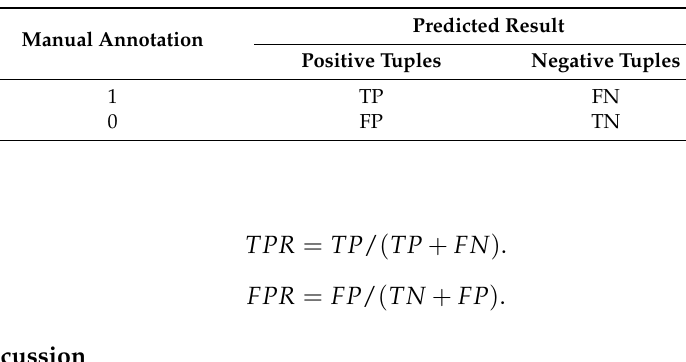
Table 2. Confusion matrix of classification results.